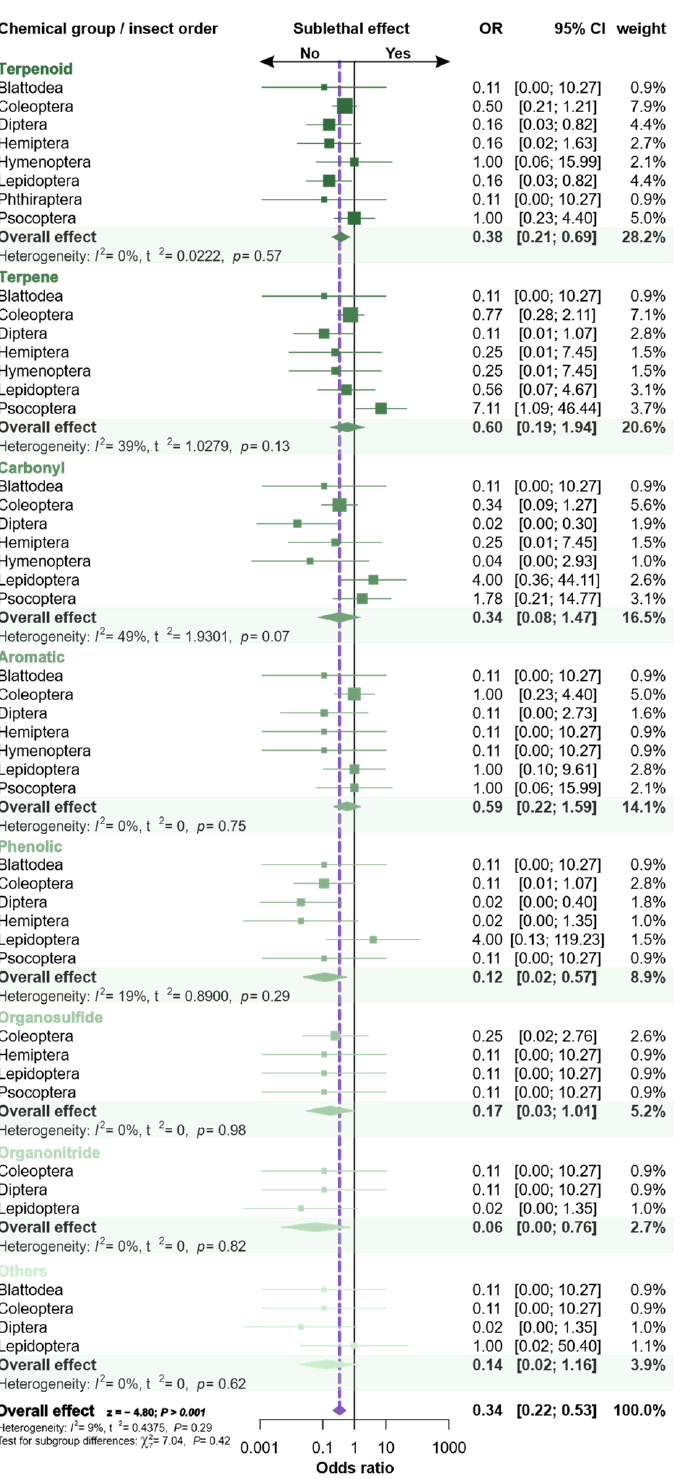
Figure 7. Forest plot summarizing the binary meta-analysis evaluating the existence or not of sublethal assessment in articles on the insecticidal activity of phytochemicals. The meta-analysis is divided into phytochemical groups and insect orders (subgroups). The proportion is denoted by colored boxes and the 95% CIs are the horizontal lines. The overall trends are represented by a colored diamond, where the diamond width corresponds to 95% CI bounds. The vertical dashed line shows the overall estimated effect resulting from all studies. The p -values for the heterogeneity test are indicated (number of papers = 138).